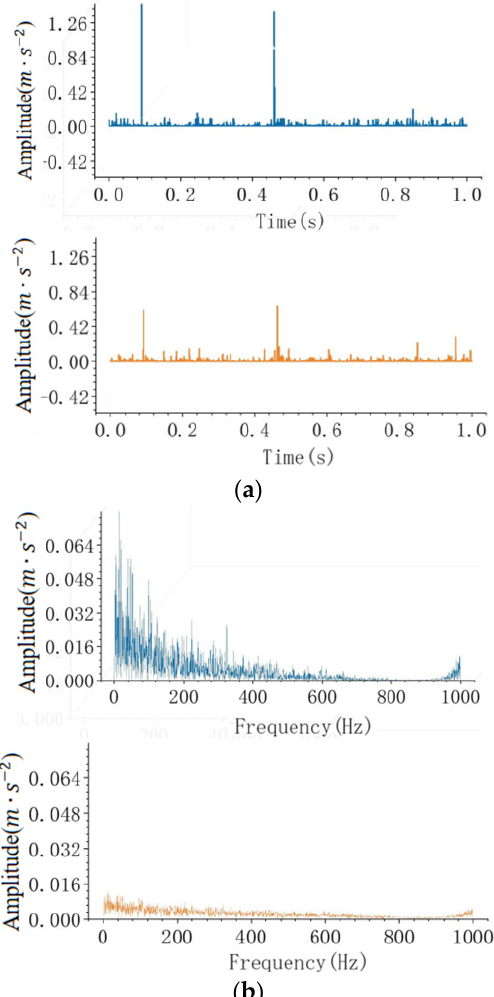
Figure 17. Time-domain/envelope results of sparse decomposition simulation. ( a ) MC penalty func- tion sparse decomposition time domain graph, and ( b ) MC penalty function sparse decomposition envelope spectrogram.